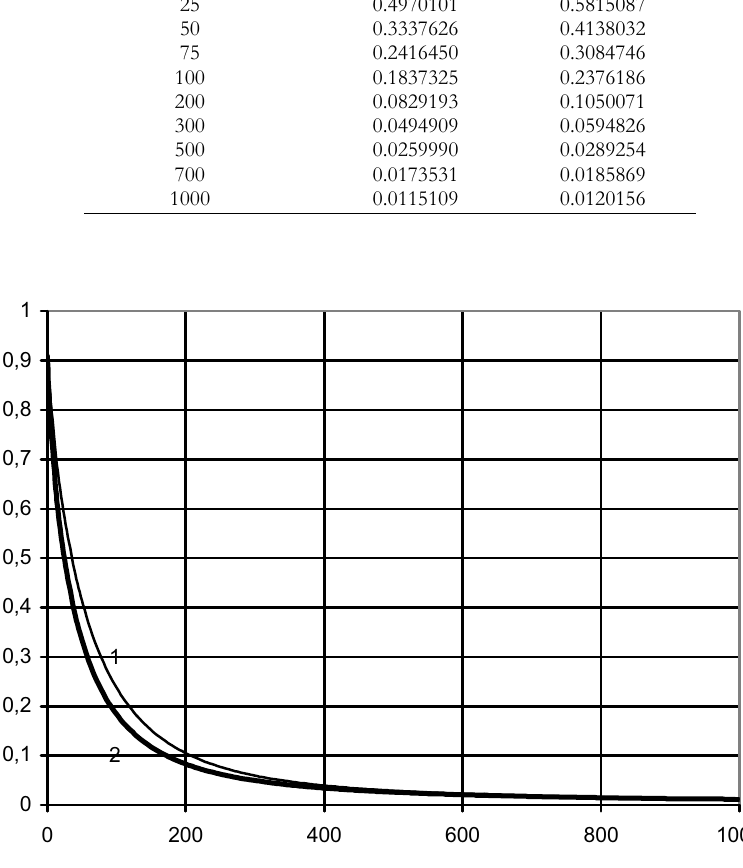
Figure 2 – Pareto, with mean 1, (cid:79) =1/1.1, using 320 discretization points. 1. Goovaerts’ and De Vylder’s